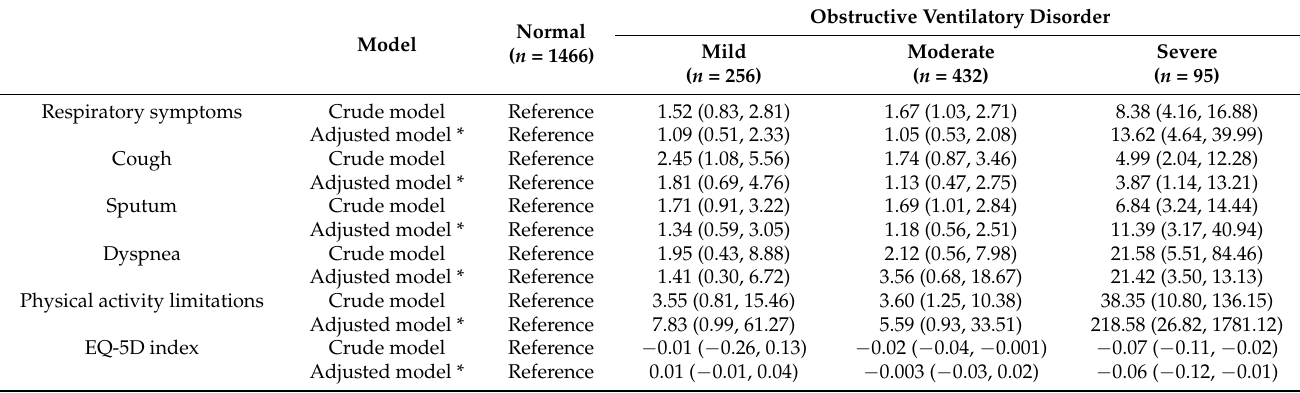
Table 3. The impact of obstructive ventilatory disorder severity on respiratory symptoms, physical activity limitations, and EQ-5D index value in subjects with prior TB.